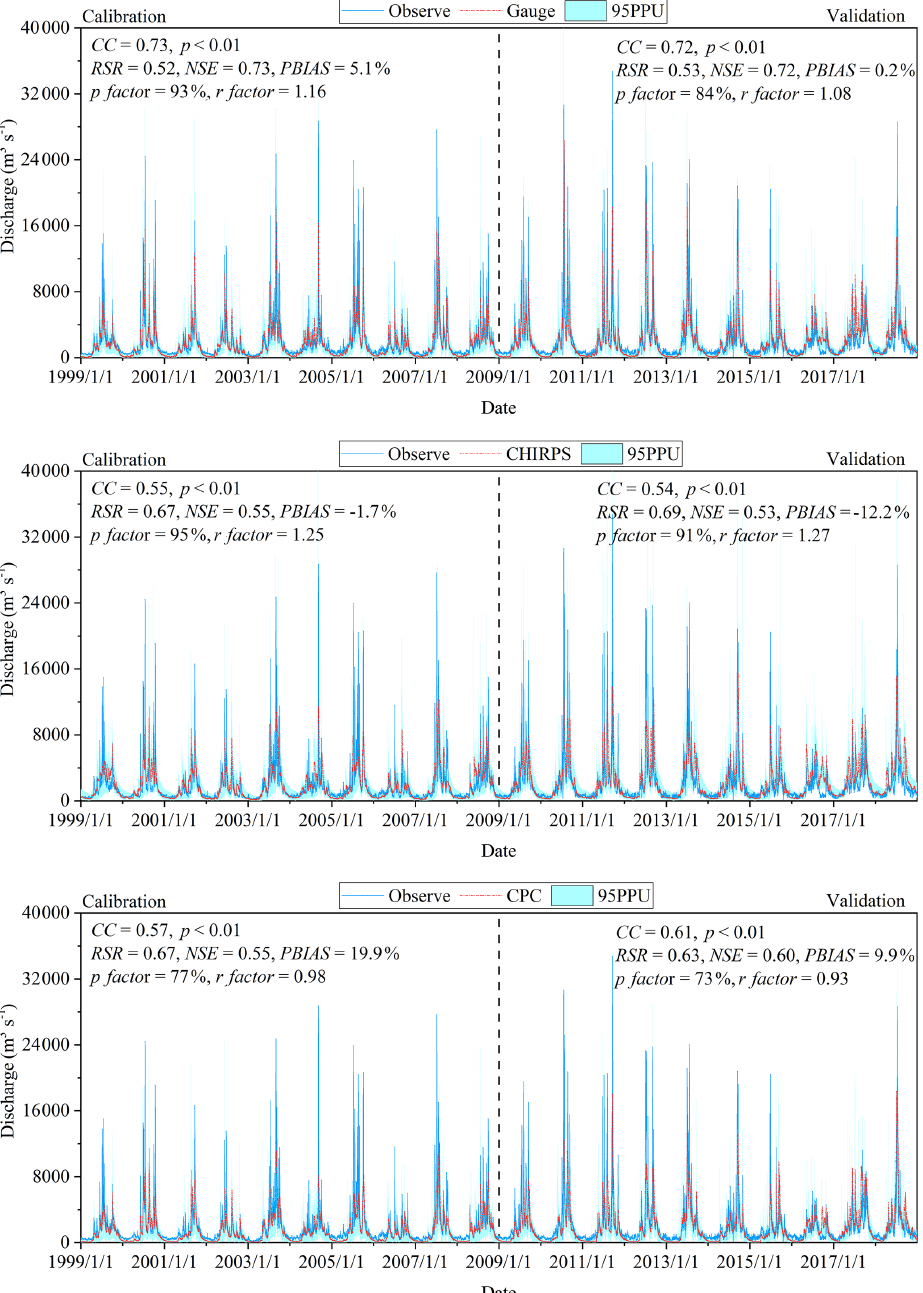
Figure 11. Observed and simulated discharges at the outlet of the JRW at a daily scale using precipitation inputs of Gauge, CHIRPS, and CPC, respectively. Please note that the date in this figure is given as